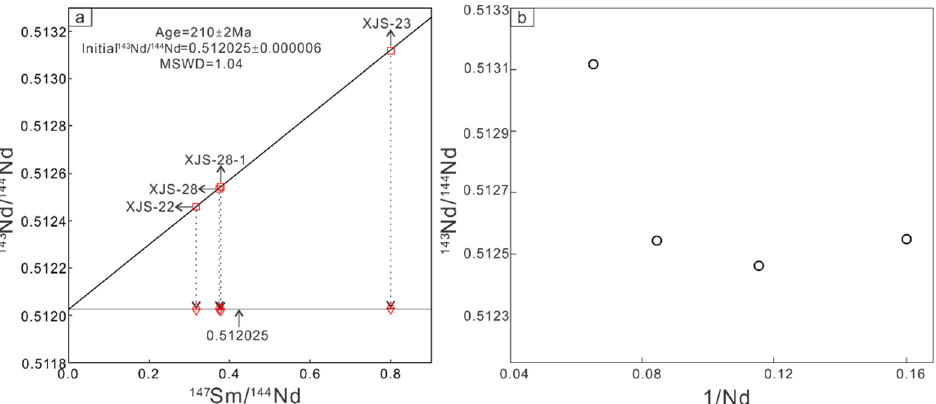
Figure 10. ( a ) Sm-Nd isochron data (□) and initial 143 Nd/ 144 Nd values at an age of 210 Ma (◊) and ( b ) 143 Nd/ 144 Nd-1/Nd plots ( ○ ) of Sch1 samples from the Longshan Sb-Au deposit.